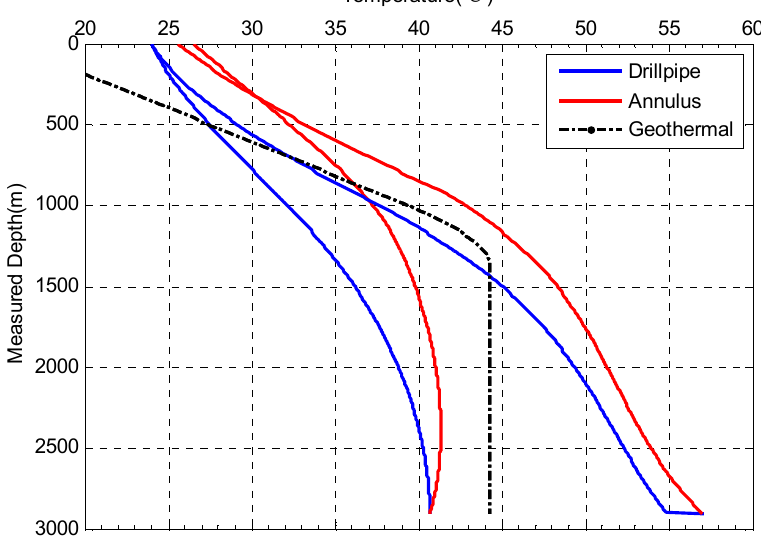
Figure 13. Temperature distribution considering the effects of drill pipe rotation, and hydraulic and mechanical frictions.